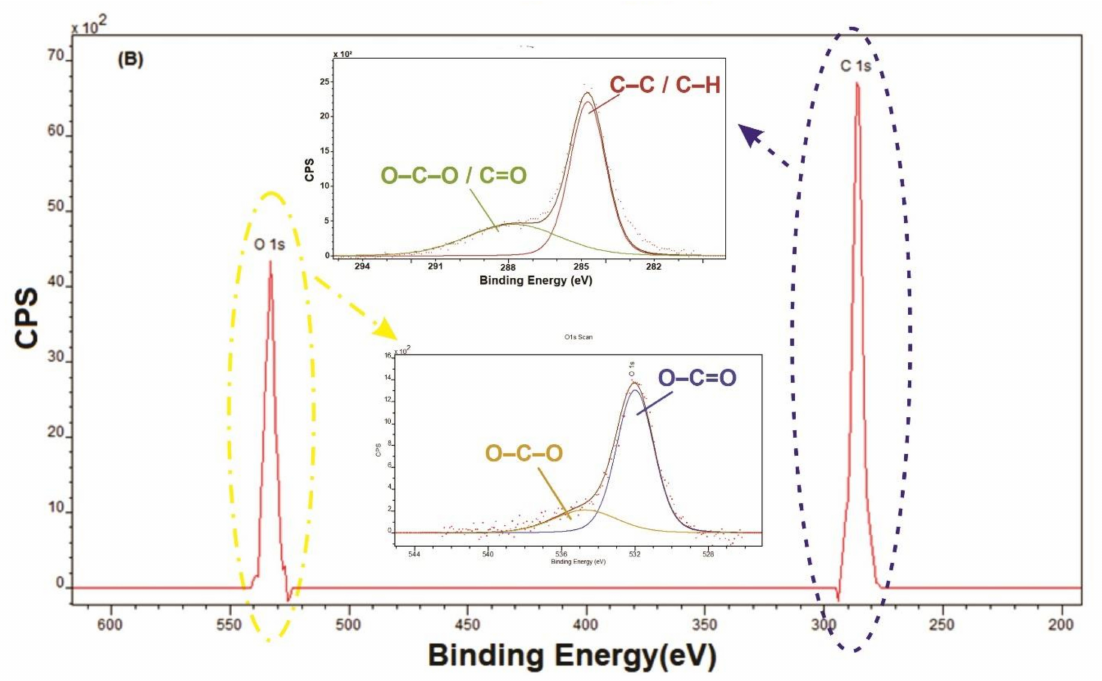
Figure 10. XPS analysis ( A ) before and ( B ) after treatment of argon plasma treatment.